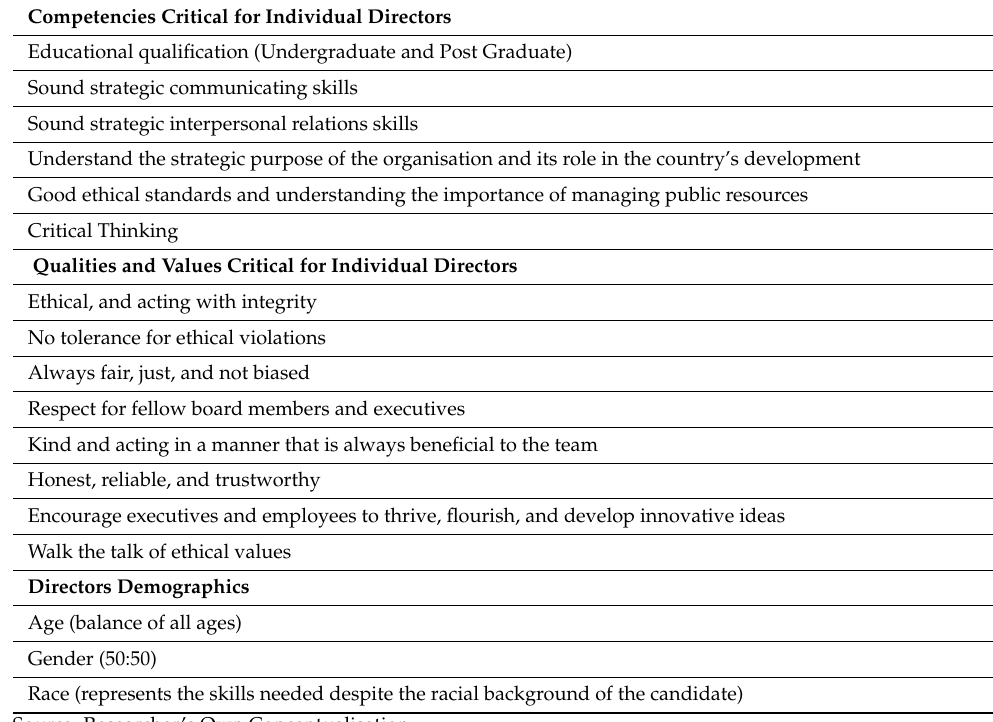
Table 1. Comprehensive list of Competencies and qualities required from a director serving in an SOC. Competencies Critical for Individual